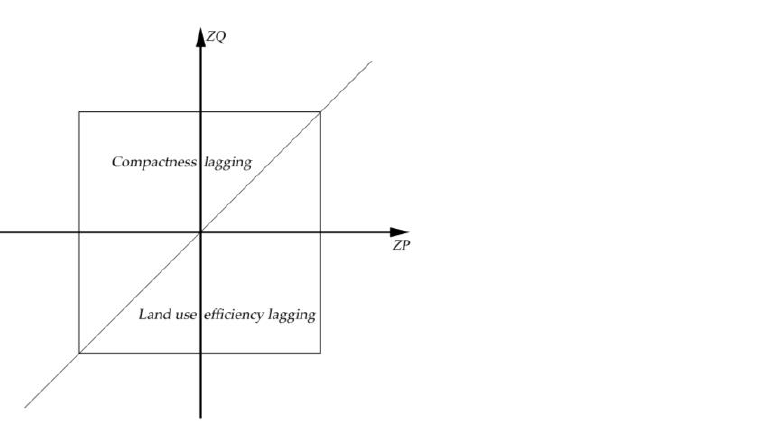
Figure 3. The quadrant diagram of the relationship between the compactness and land-use efficiency. (Source: Authors).